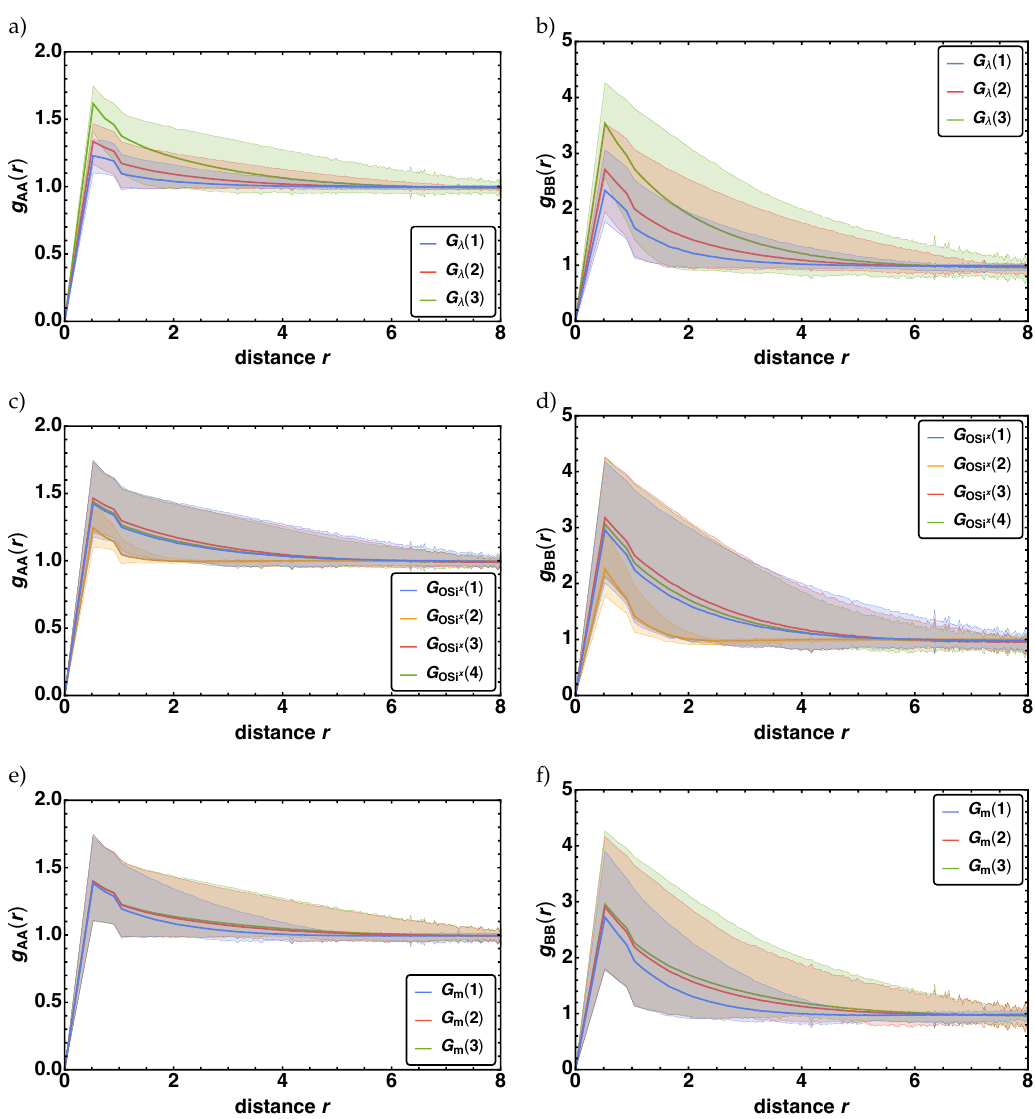
Figure 9. The arithmetic mean, i.e., averaged (thick colored line), the minimum (lowest thin colored line) and the maximum (highest thin colored line) radial distribution function g βα ( r ) over radial distance r are given for ba = fAA, BBg in ( a , c , e ) and ( b , d , f ) and for the parameter groups G λ , G OSi x , and G m in ( a , b ), ( c , d ), and ( e , f ). Each subgroup i is highlighted with a different